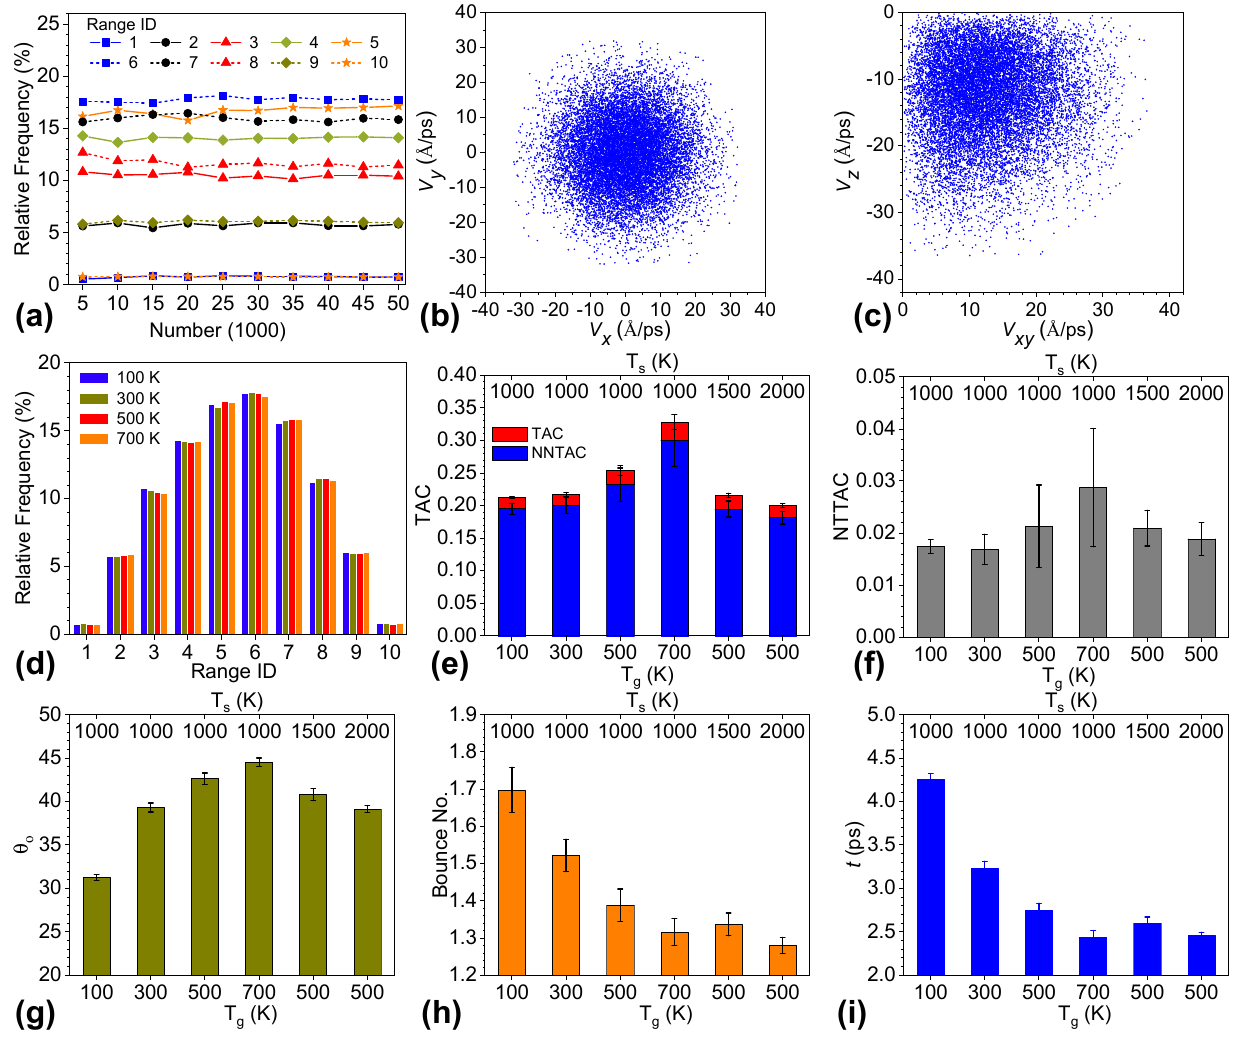
Figure 6. ( a ) Convergence analysis of the relative frequency of the zenith angle of incident helium. Range ID of 1 to 10 represents zenith ranges of [0°,5°], [5°,15°], … [85°,90°]. For each middle range ID, the interval width was 10°. ( b ) Scatterplot of in-plane velocity components of sampled incident helium. ( c ) Scatterplot of normal and in-plane velocity components of sampled incident helium. ( d ) Converged relative frequency in various ranges of θ in for helium with different incident speeds. ( e ) TAC and NNTAC and ( f ) NTTAC for systems with various graphene temperatures denoted by top tick labels and helium incident speeds shown by bottom tick labels. ( g ) Zenith angle of scattered helium, ( h ) bounce number, and ( i ) interaction time of helium for various